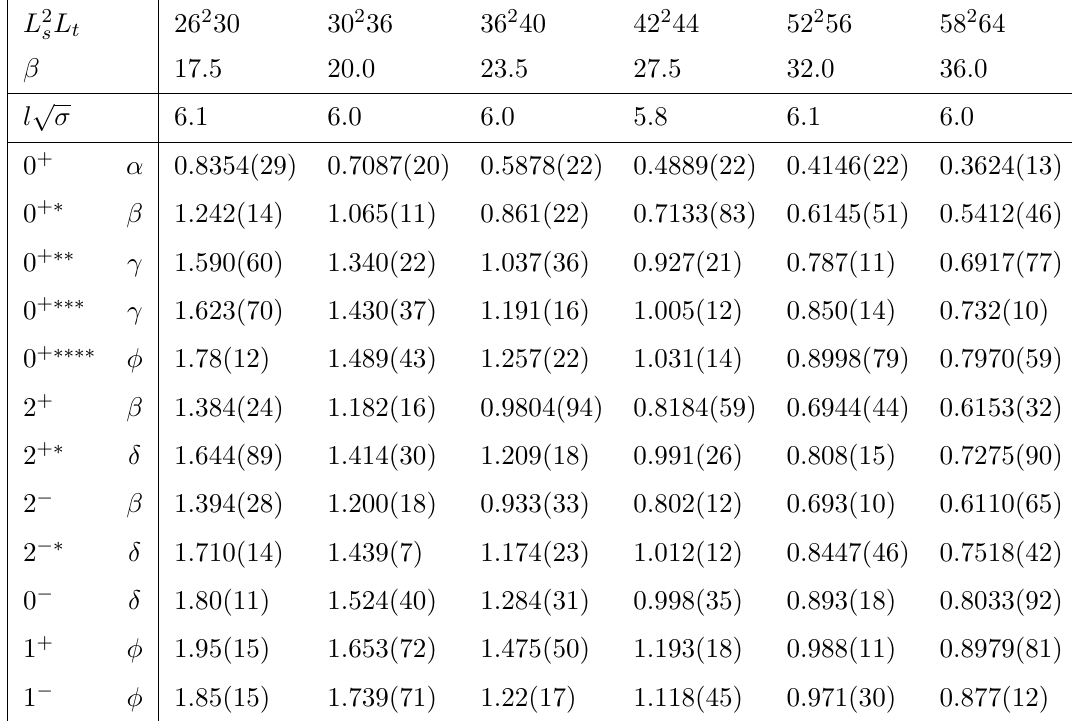
Table 22 . SO(5) glueball masses am G . Grades, e.g. (cid:11) , explained in section 3.6.6.